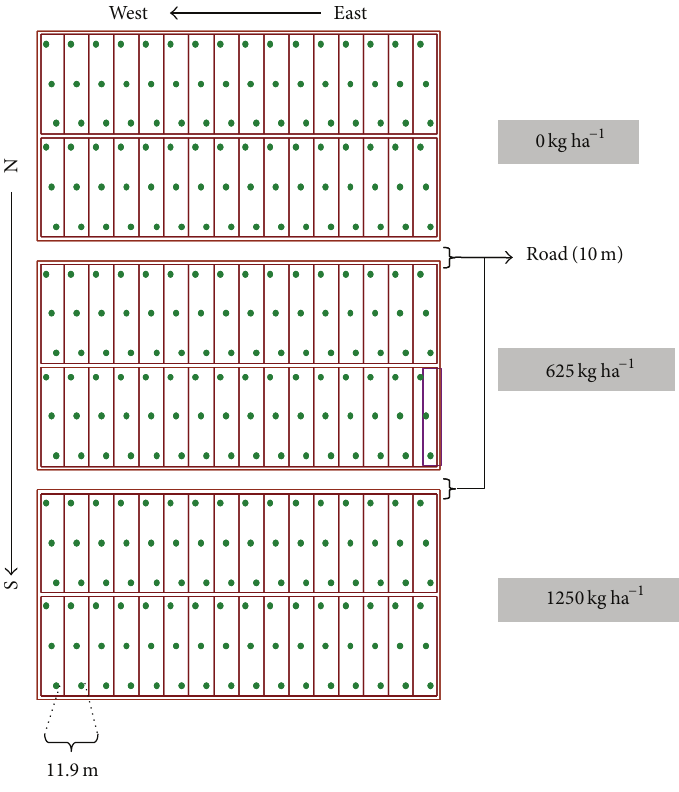
Figure 1: Sampling grid with 96 sampling positions per treatment.